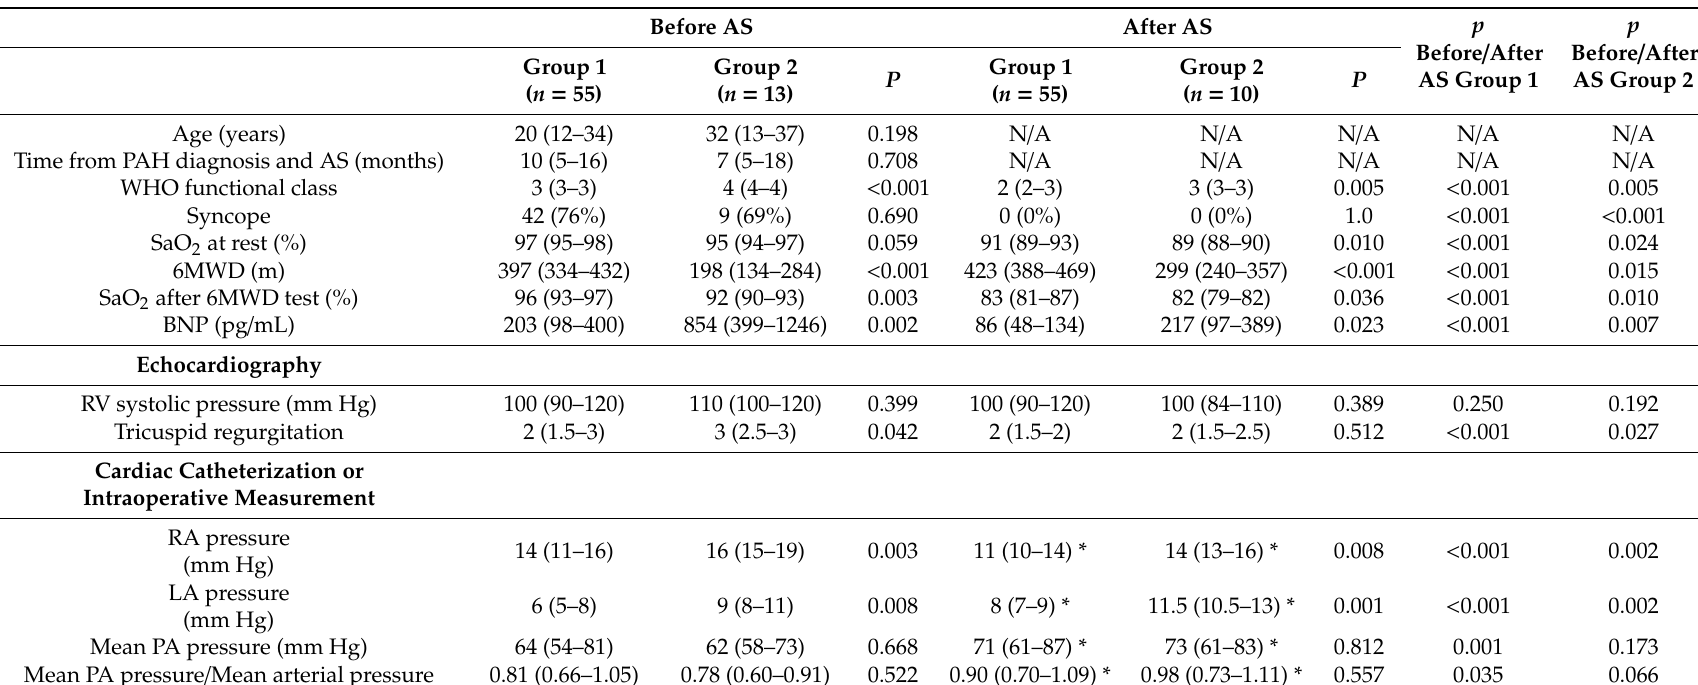
Table 2. Clinical and hemodynamic parameters before and at discharge after atrial